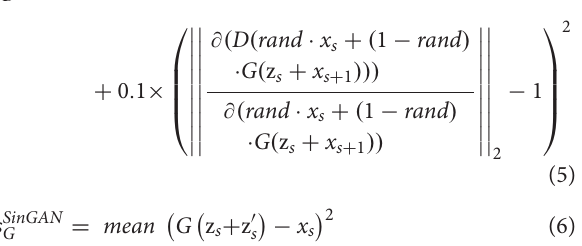
network performs four deconvolutions, and the number of feature maps decreases from 1024 to 128, so the output data size is 64 × 64 × 128. Finally, through a simple convolution function, the final output data size is 128 × 128 × 3. Finally, a Tanh activation function is used to make the final data comparable to the original